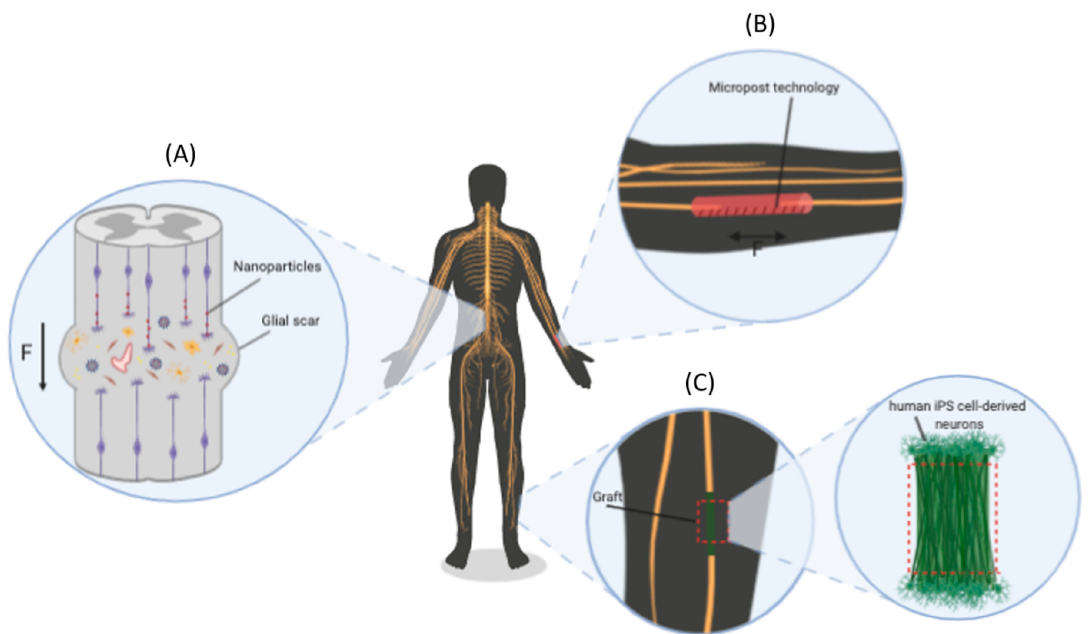
Figure 4. Novel therapeutic perspectives for inducing nerve regeneration through mechanical forces: ( A ) stimulation of SG of resident injured neurons via MNP labelling and their magnetic manipulation, ( B ) magnetically actuated microposts integrated in MEMs for the generation of an implantable scaffold, and ( C ) patient iPS-derived neurons stretched in vitro and used to produce implantable grafts to repair nerve gaps [173].